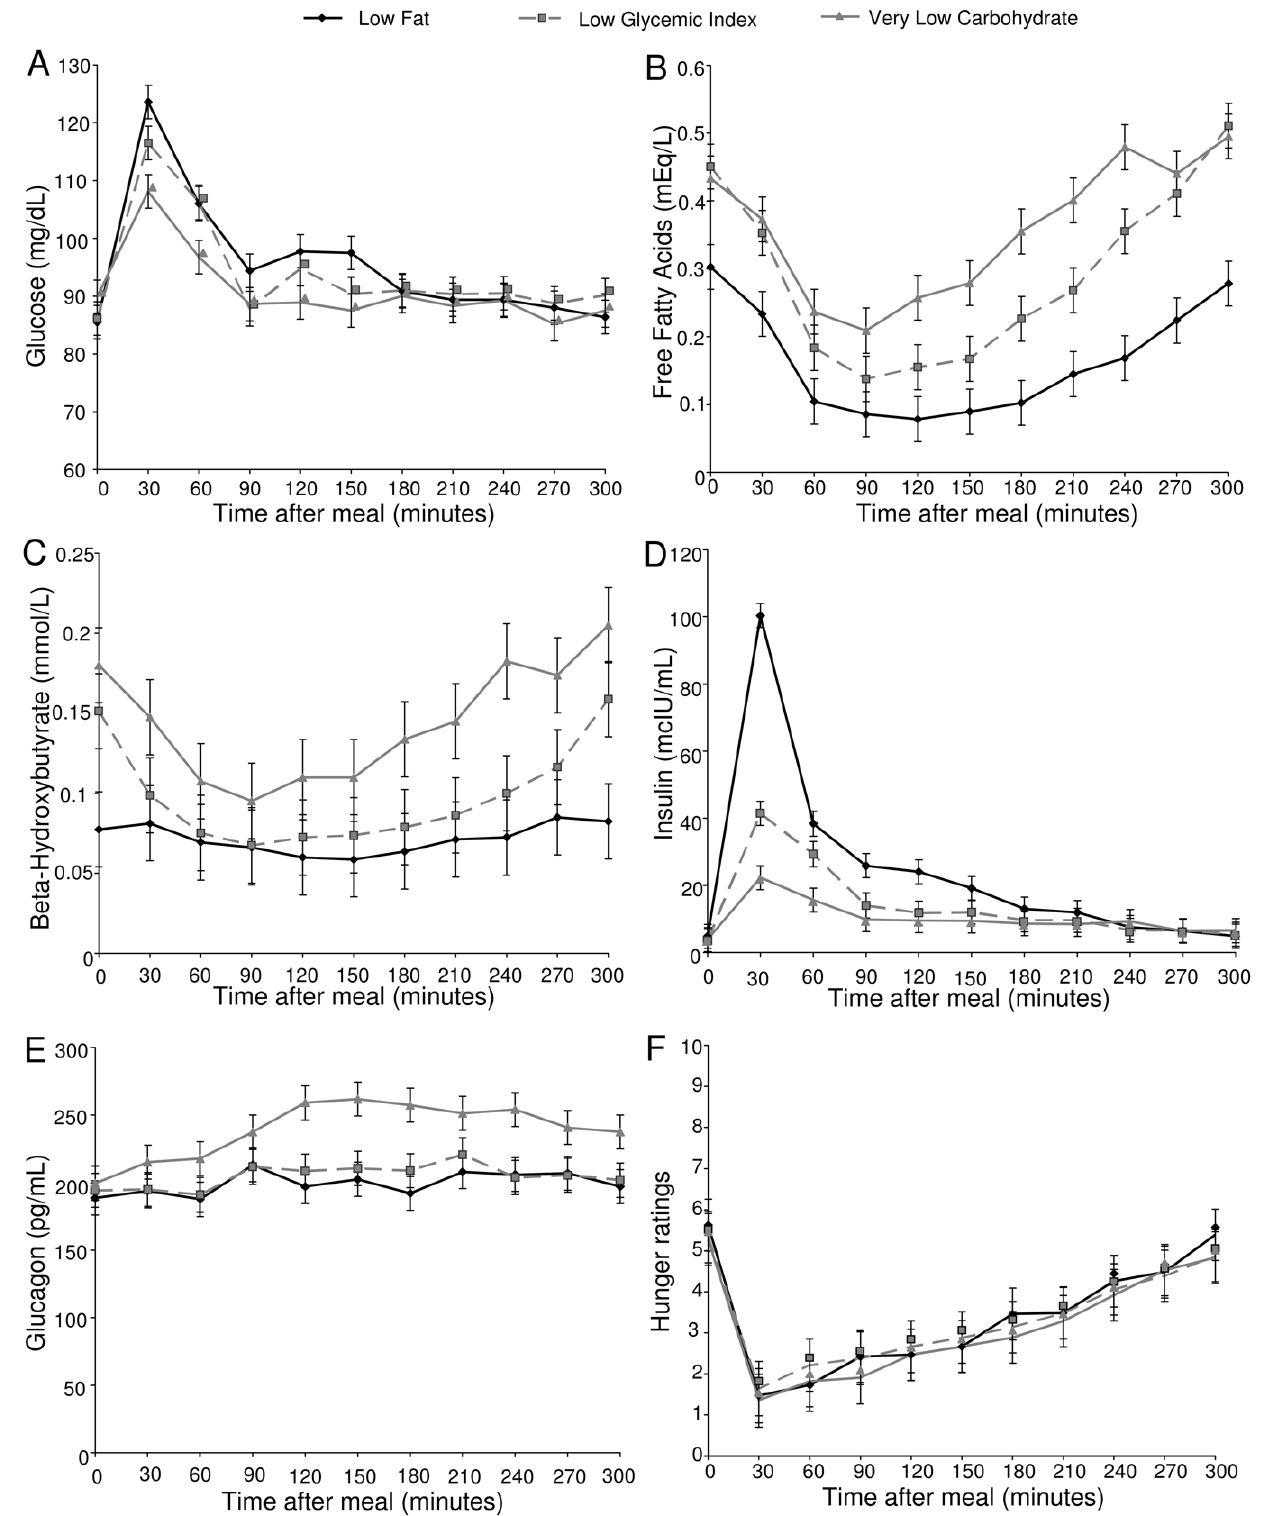
Figure 2. Postprandial levels of metabolic fuels, hormones, and hunger. The figures show levels of glucose (Panel A, mg/dL), free fatty acids (Panel B, mEq/L), b -hydroxybutyrate (Panel C, mmol/L), insulin (Panel D, mcIU/mL), and glucagon (Panel E, pg/mL), and hunger ratings (Panel F). Error bars represent the standard error of the mean from fitted repeated-measures model.